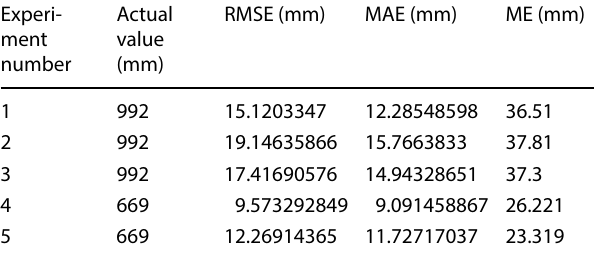
Table 2 Crop height measurement data Experi-